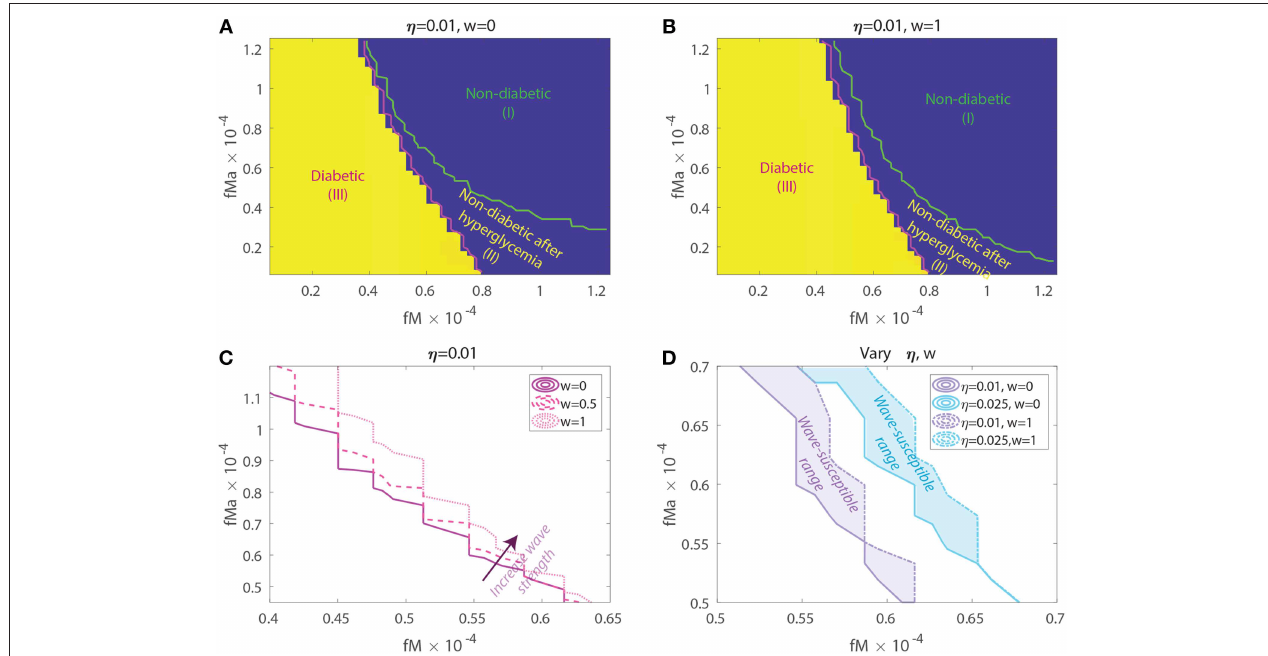
FIGURE 7 | Susceptibility to acquiring diabetes as a function of apoptotic wave strengths w , macrophage clearance rates f M and f Ma , and of baseline T-effector activity, η . (A) No apoptotic wave: Heat map of model glucose values at 142.85 weeks for varying macrophage clearance rate combinations without apoptotic wave. (B) With apoptotic wave: Heat map of model glucose values at 142.85 weeks for varying macrophage clearance rate combinations. (C) Changes in healthy boundary between region (III) and (II) as wave scaling, w , is increased with fixed η = 0.01. (D) Clearance rate regions that transition from a healthy to a diseased state with the addition of the wave (wave susceptibility range in shaded regions). Two susceptibility regions are computed, one for η = 0.01 and one for η = 0.025.